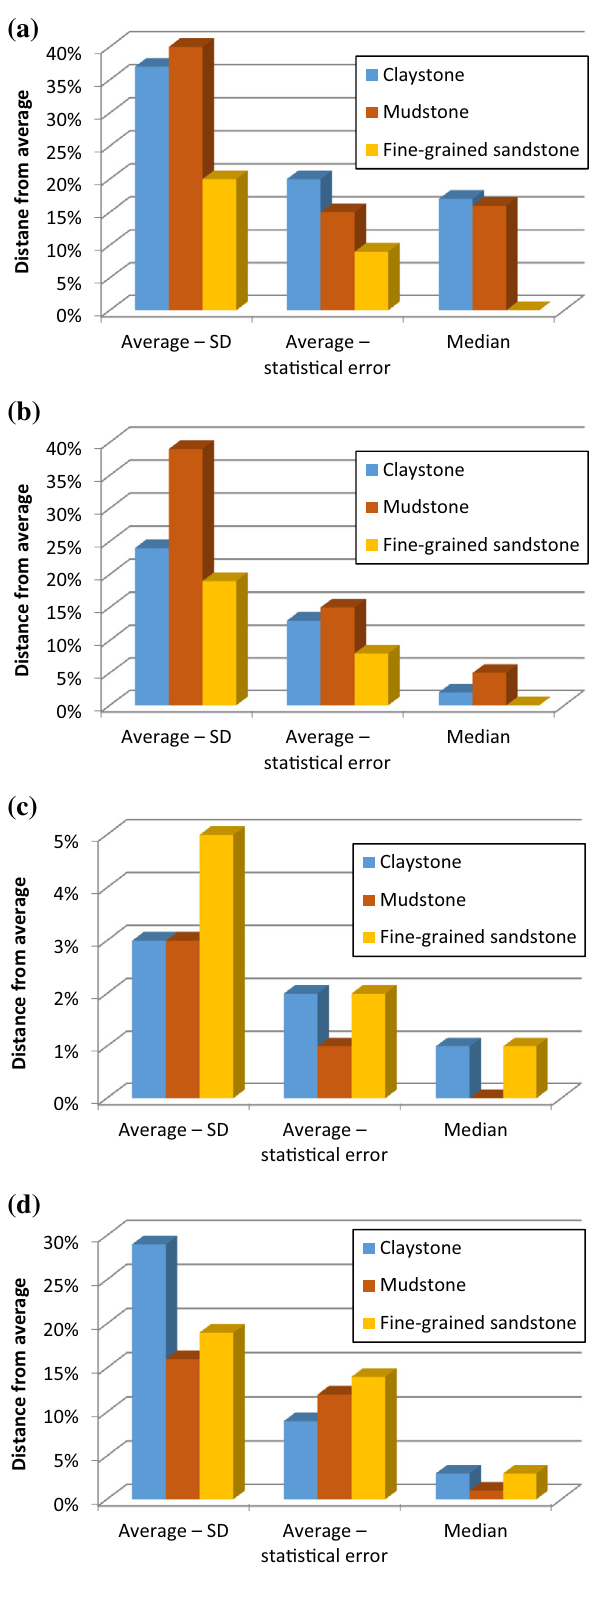
b Fig. 9 Difference between the geomechanical parameters of Case 1 (average) and the other three cases: a compressive strength, b tensile strength, c unit weight, and d